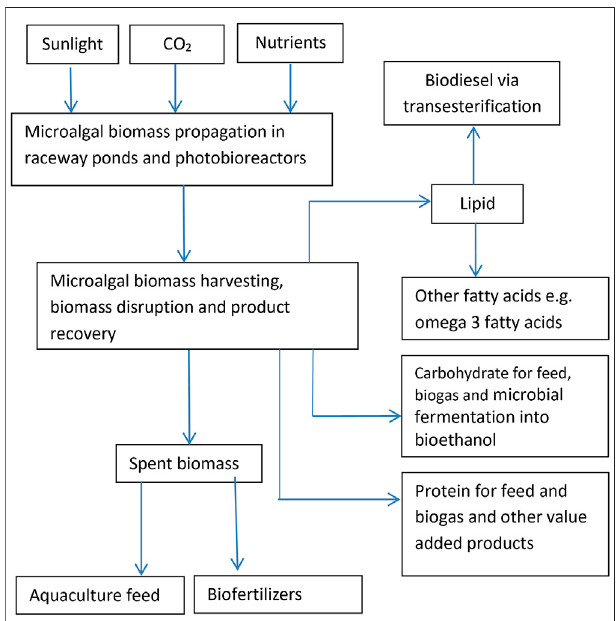
FIGURE 1 | Schematic illustration of the microalgal biomass biore fi nery